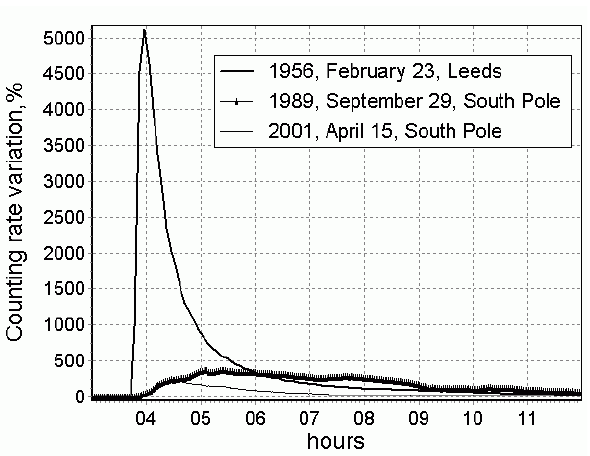
Figure 2 Fig. 2. Counting rate variations at Climax neutron monitor and Ap index of geomagnetic activity in February 1956. Great fluxes on 23 February are not plotted. Triangles at the top of the figure corre- spond to the